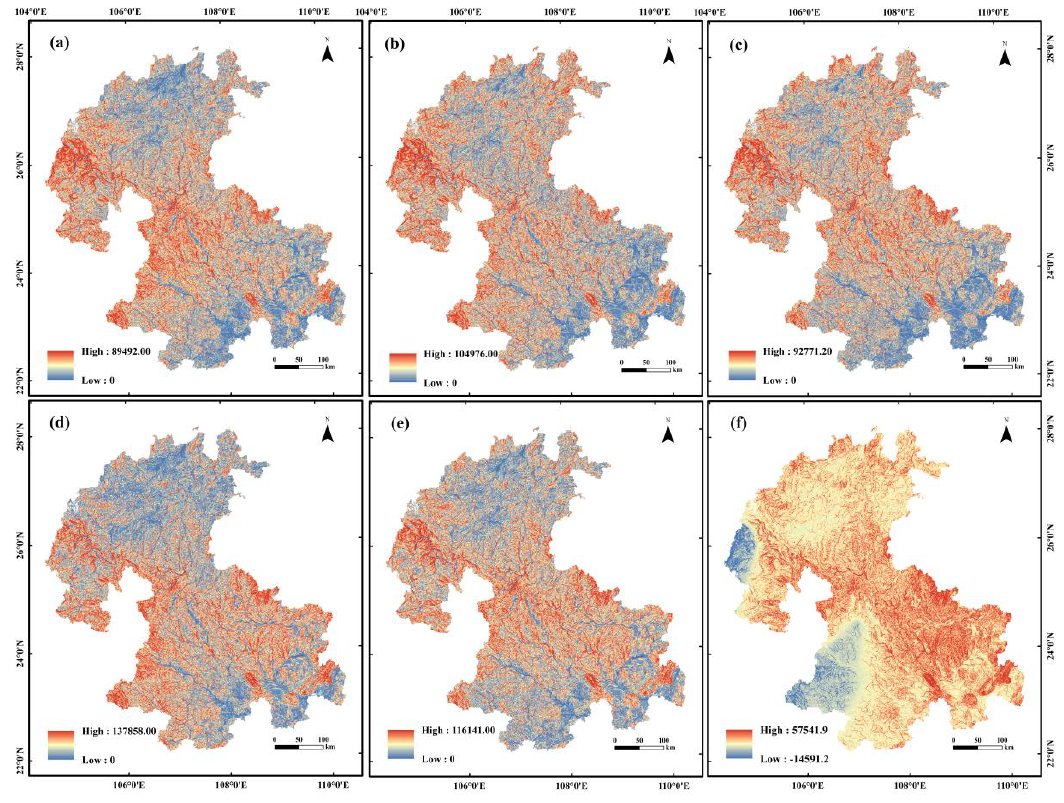
Figure 5. Soil conservation quantities from 1990 to 2010, ( a ) 1990, ( b ) 1995, ( c ) 2000, ( d ) 2005, and ( e ) 2010, and ( f ) soil conservation variations from 1990 to 2010 (all units are in t/km 2 ).